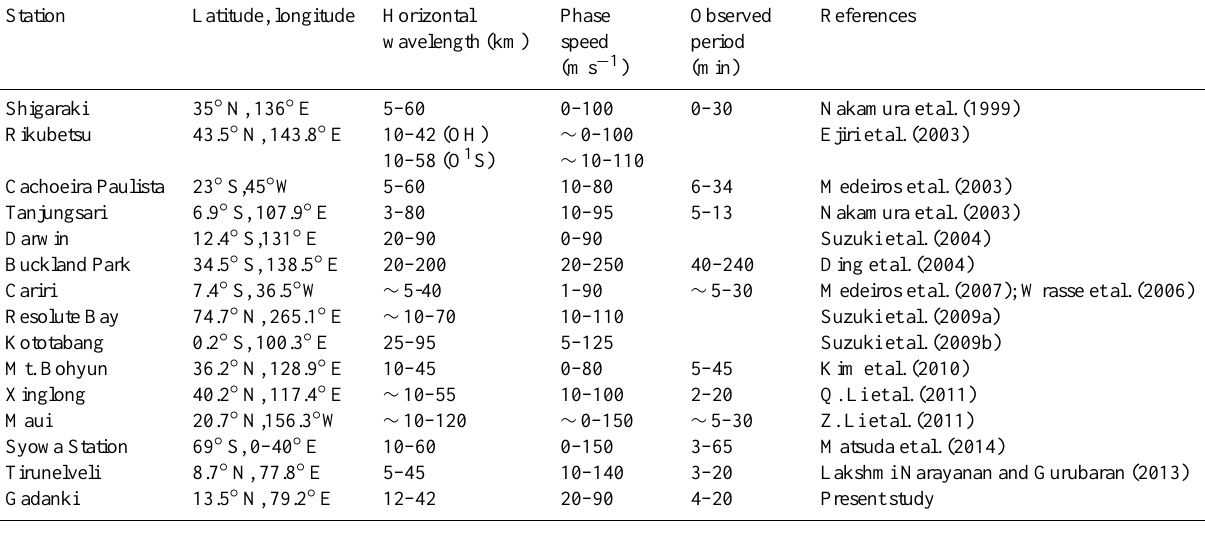
Table 2. Comparison of the present results with earlier small-scale wave measurements.